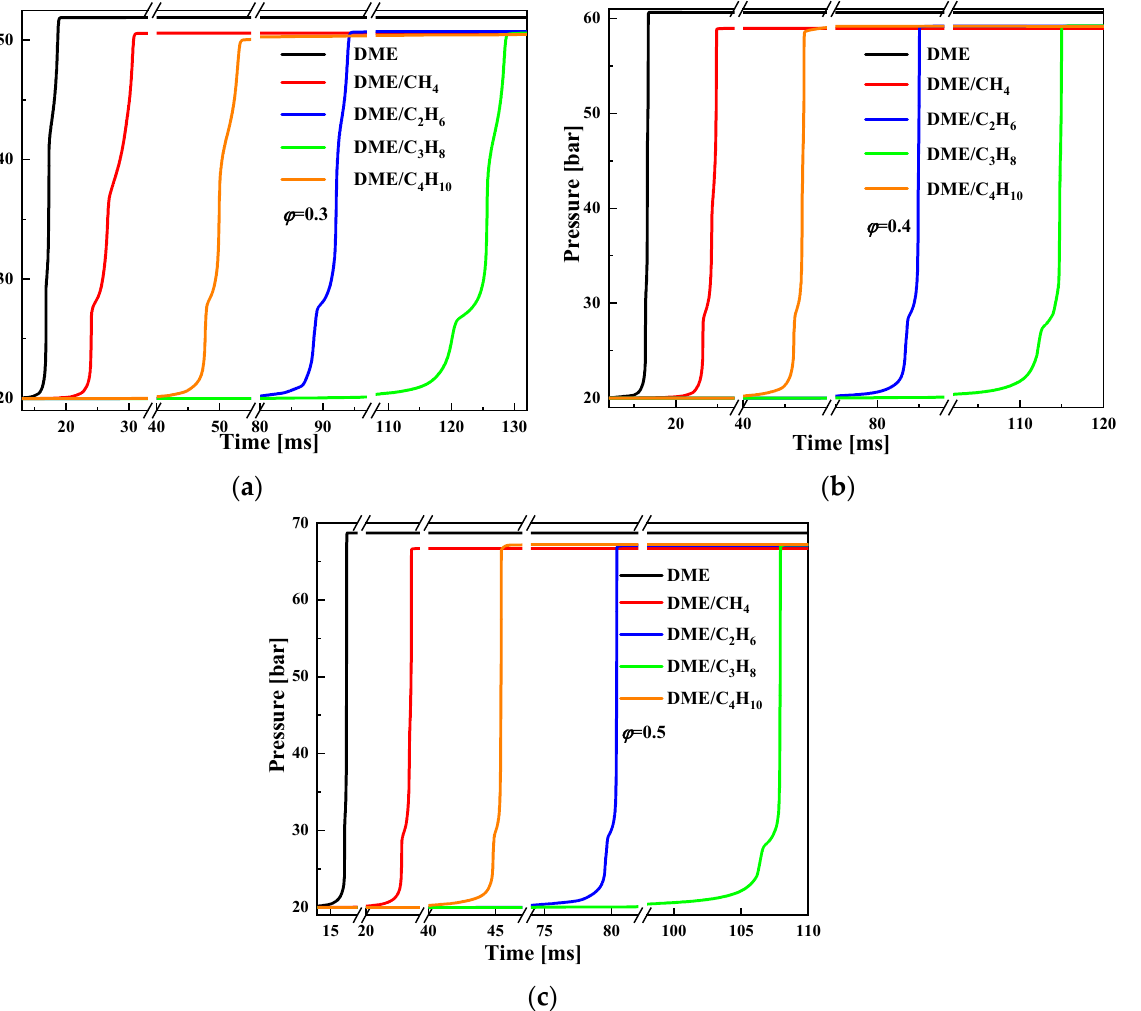
Figure 11. Comparison of pressure of DME/C1-C4 alkane mixtures for various equivalence ratios at T c = 650 K and P c = 20 bar: ( a ) φ = 0.3; ( b ) φ = 0.4; and ( c ) φ = 0.5.